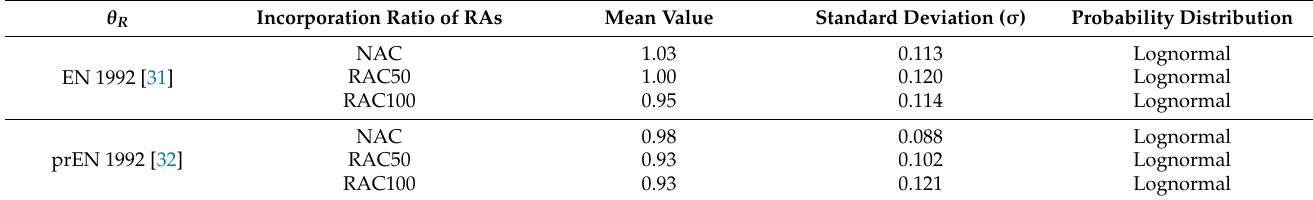
Table 6. Stochastic modelling of the model uncertainty of elements without shear